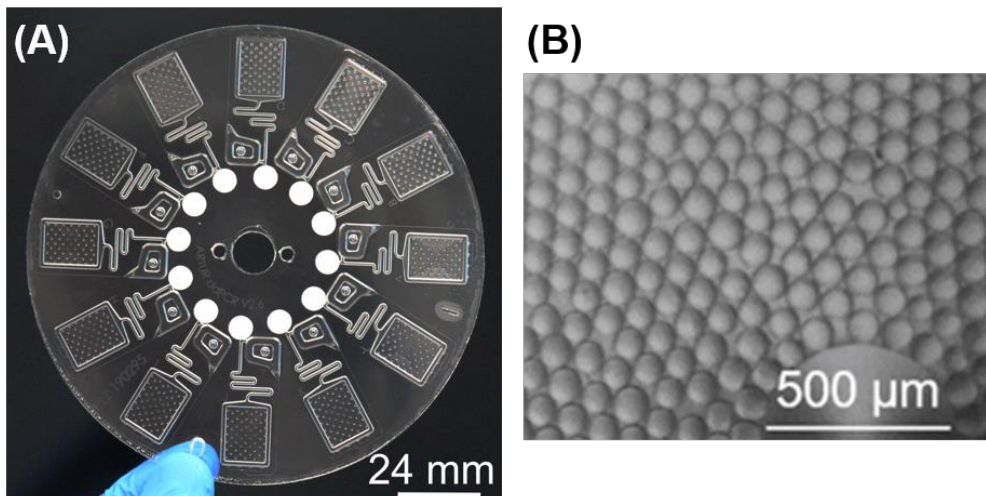
Figure 3. ( A ) The LabDisk with 12 identical ddPCR units manufactured with cyclo-olefin copolymer (COC) foil technology. On the far side, each vent is closed by a white polytetrafluoroethylene (PTFE) membrane. ( B ) Bright field microscopy image of droplets generated with PerfeCTa MultiPlex qPCR Toughmix in a ddPCR unit.